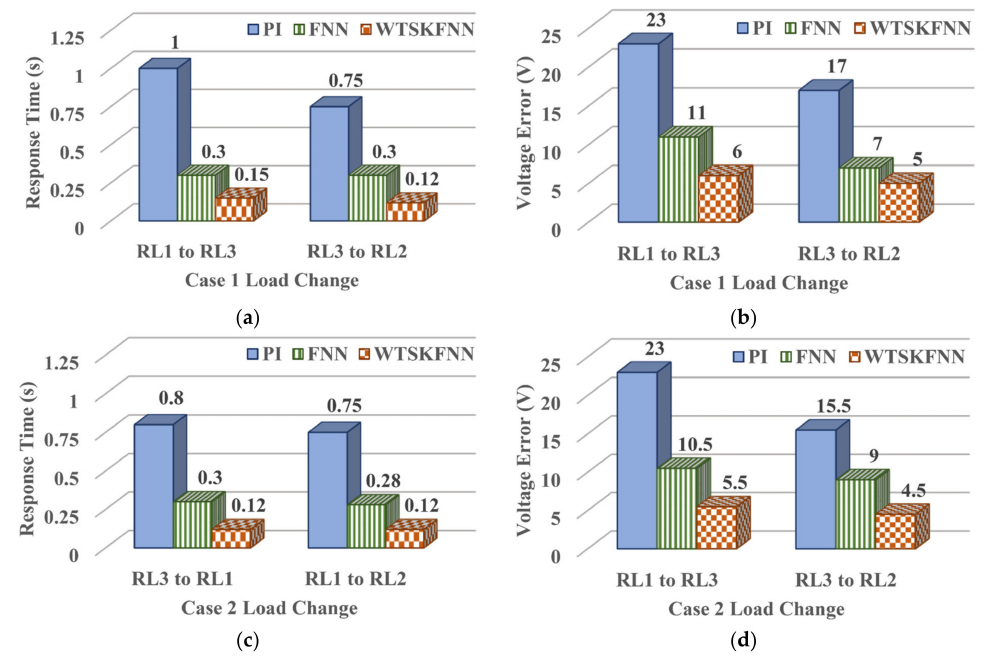
Figure 11. Transient response under load variation. ( a ) Response times of grid currents using different controller in Case 1; ( b ) DC-link voltage error of different controller in Case 1; ( c ) Response times of grid currents using different controller at Case 2; and ( d ) DC-link voltage error of different controller in Case